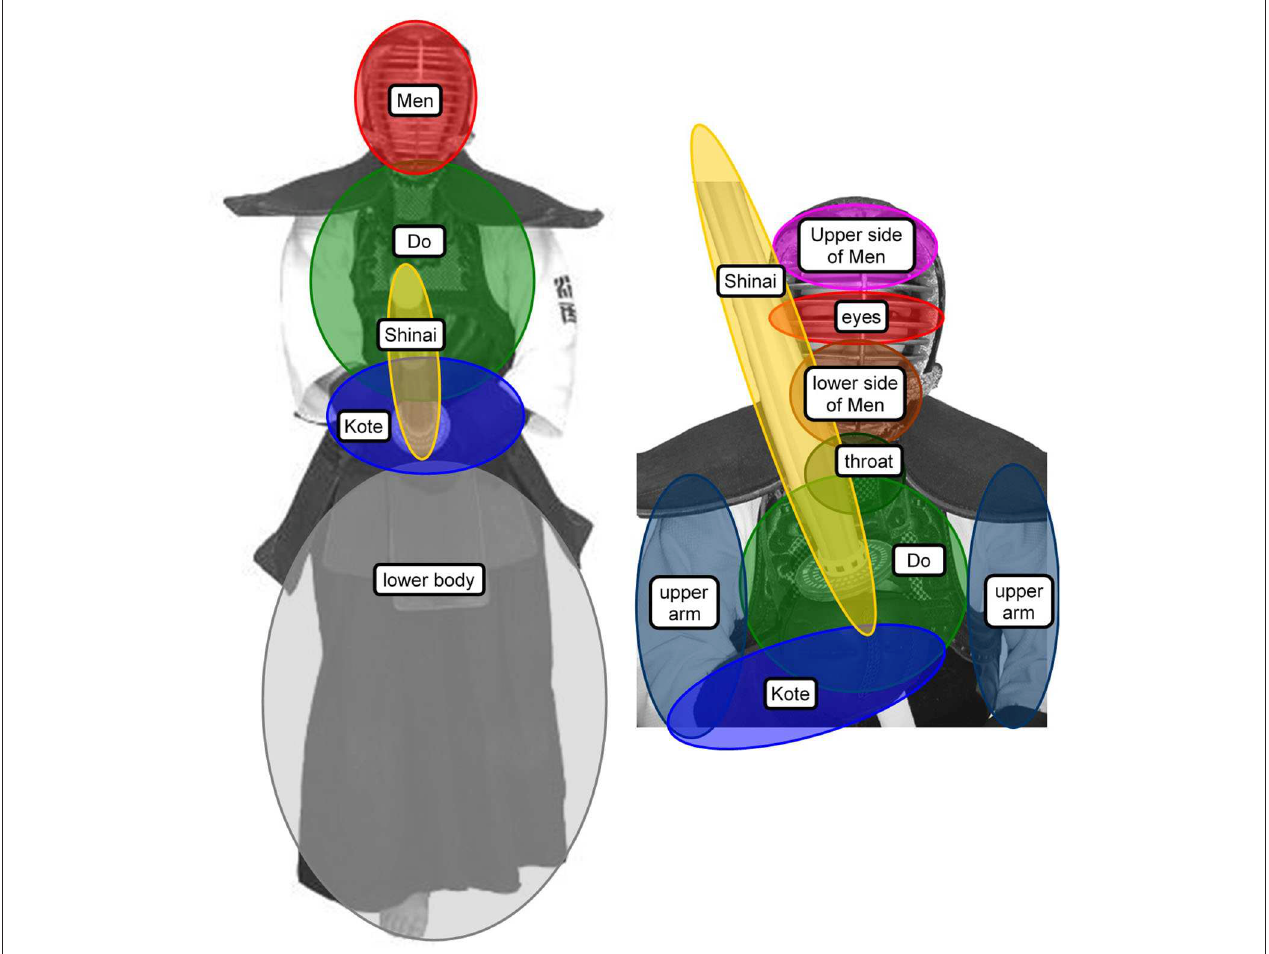
FIGURE 3 | The area of fixation location chosen for the study ( Left , the five areas considered the whole body in S1, S3, S4, and S5; Right , a more specific eight areas in the Tsubazeriai distance in